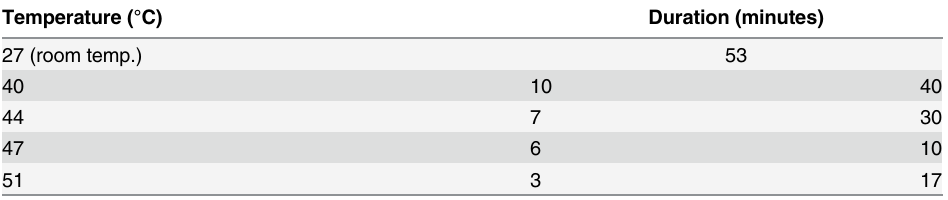
Table 2. Experimental treatment setup for the follow-up water bath experiment using E . atala pupae. Temperature (°C) Duration (minutes) 27 (room temp.) 53 40 10 40 44 7 30 47 6 10 51 3 17 Each temperature and duration combination included a total of 6 pupae representing 6 ages since pupation: 2, 6, 7, 8, 11, and 15 days since pupation. Duration pairs for each temperature are for previously observed survival (low duration) and non-survival (high